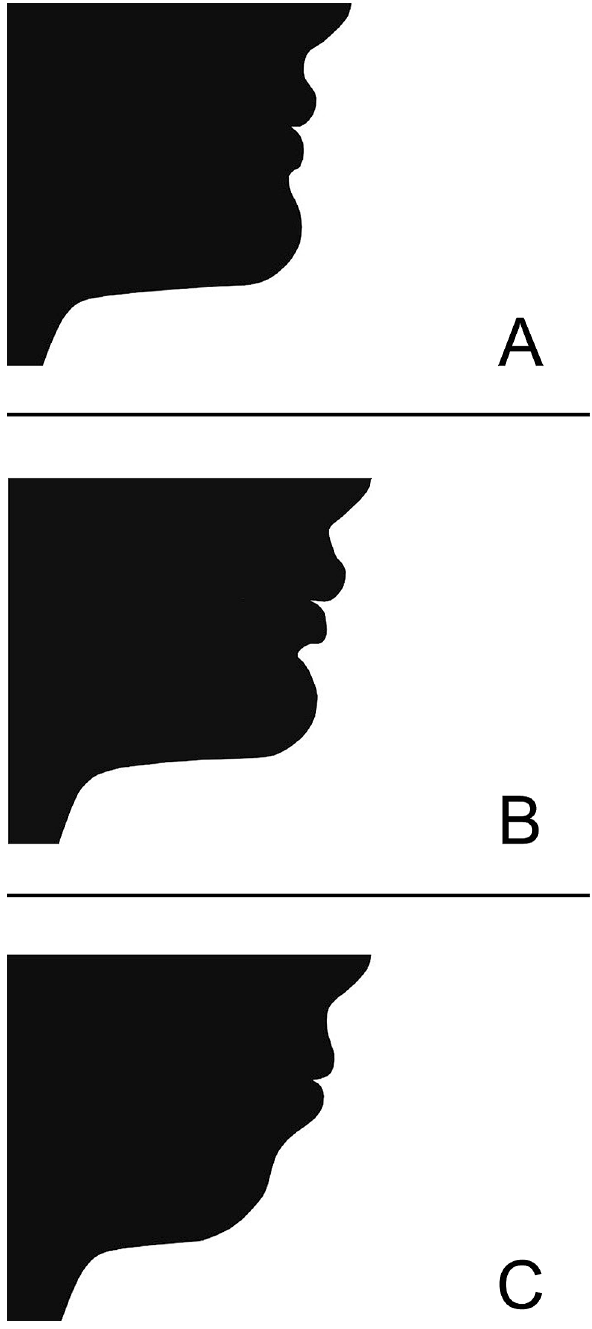
Figure 2. Calibration silhouettes showed to the observers for evaluation. ( A ) Calibration profile no. 1 depicting a “very pleasant” profile; ( B ) calibration profile no. 2 depicting a “medium” profile; ( C ) calibration profile no. 3 depicting a “very unpleasant”